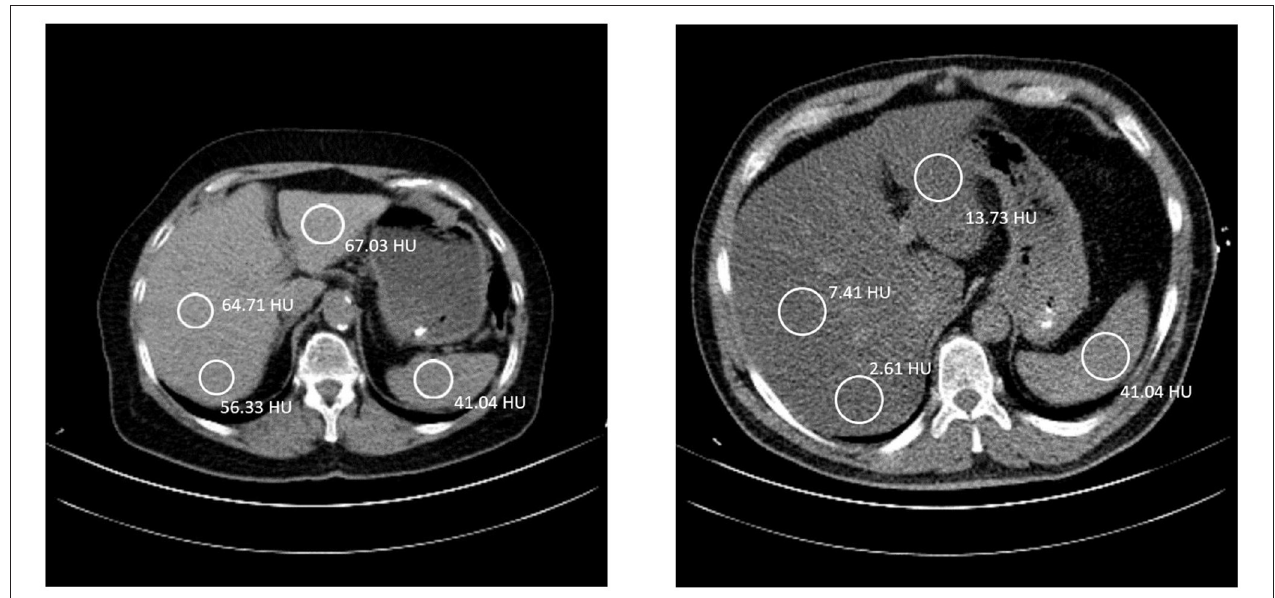
FIGURE 1 | Left : A 70-year-old female, with liver to spleen ratio (L/S) of 1.15. The coloration of the liver is clearly brighter than the spleen. She has a BMI of 26.0 kg/m 2 and has been diagnosed with hypertension, dyslipidemia, and a previous myocardial infarction. Right : A 50-year-old male, with L/S ratio of 0.12. The liver has a much darker color than the spleen, indicating a fatty liver. He has a BMI of 30.0 kg/m 2 and has been diagnosed with type II diabetes mellitus, hypertension, and dyslipidemia. The patient also has less subcutaneous fat and more visceral fat. In both images the table is 40cm wide. A good indication of the size difference between the two